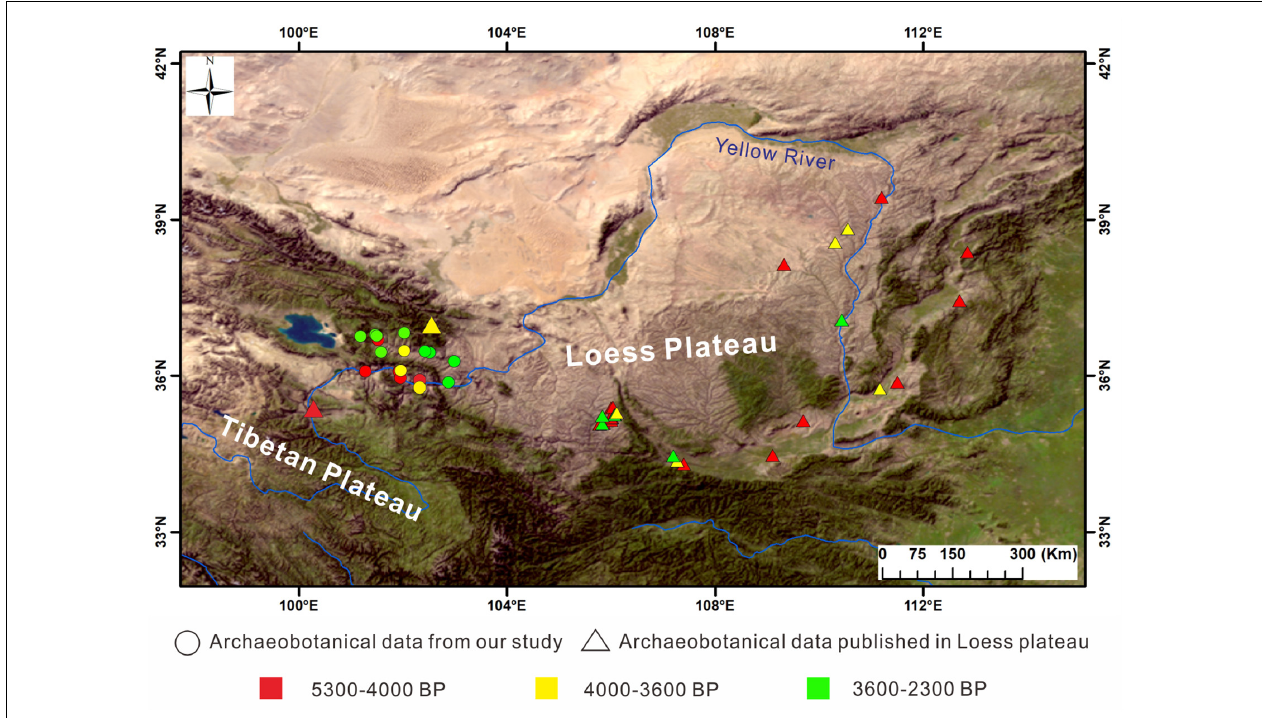
FIGURE 1 | Distribution of archeological sites yielding charcoal analyses in the NETP and the Chinese Loess Plateau. Charcoal analysis sites presented in circles are located in the NETP (our new data), and those shown by triangles are in the Chinese Loess